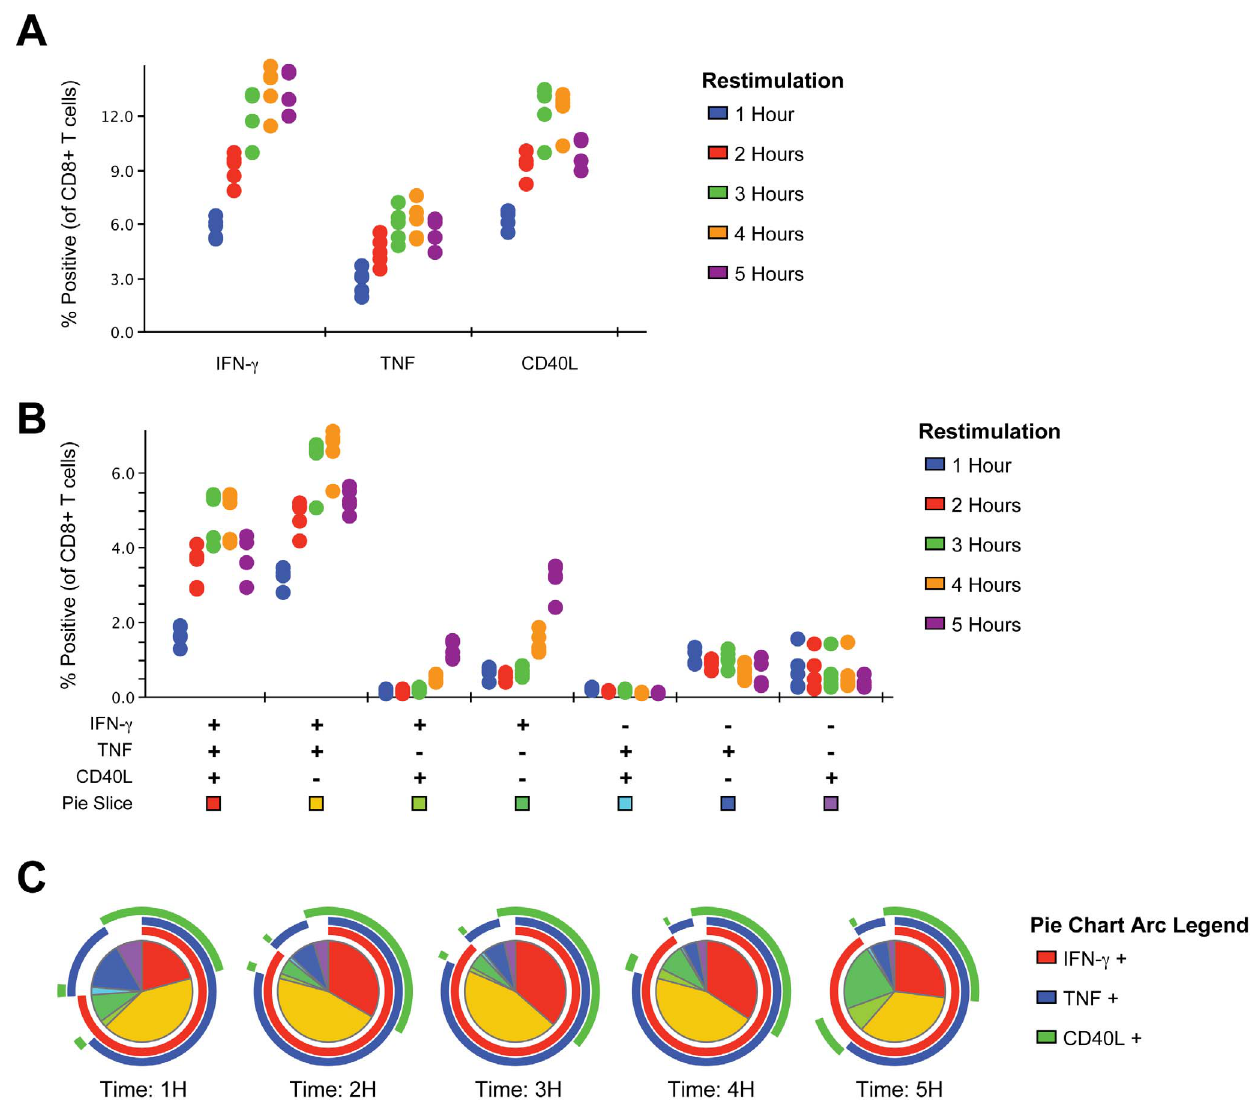
Figure 4. Rapid expression of CD40L by CD8 + T cells following restimulation. Mice were primed with 1 6 10 7 cfu Lm-QV and spleens harvest 7 days later. Splenocytes were restimulated in vitro with B8R 20–27 for the indicated time and then stained for intracellular IFN- c , TNF and CD40L. (A) Univariate analysis of intracellular IFN- c , TNF or CD40L within CD8 + T cells after restimulation. (B) Multivariate analysis of IFN- c , TNF and CD40L over time within CD8 + T cells. (C) Protein expression profile of B8R 20–27 –specific CD8 + T cells after restimulation. Pie slices correspond to color legend in panel B. Outer arcs indicate slices expressing the phenotype of the inner slices. Each point in panels A and B indicates a single animal (5 mice per group), panel C represents the median of data from panel